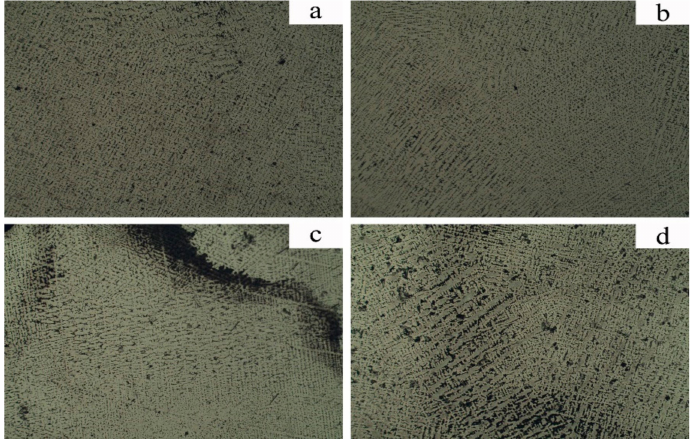
Figure 13. E ff ect of di ff erent proportions of Al 2 O 3 on the microstructure of cobalt-chromium alloy. ( a ) Metallographic diagram of alloy mixed with 2.5% Al 2 O 3 ; ( b ) metallographic diagram of alloy mixed with 5% Al 2 O 3 ; ( c ) metallographic diagram of alloy mixed with 7.5% Al 2 O 3 ; ( d ) metallographic diagram of alloy mixed with 10% Al 2 O 3 .